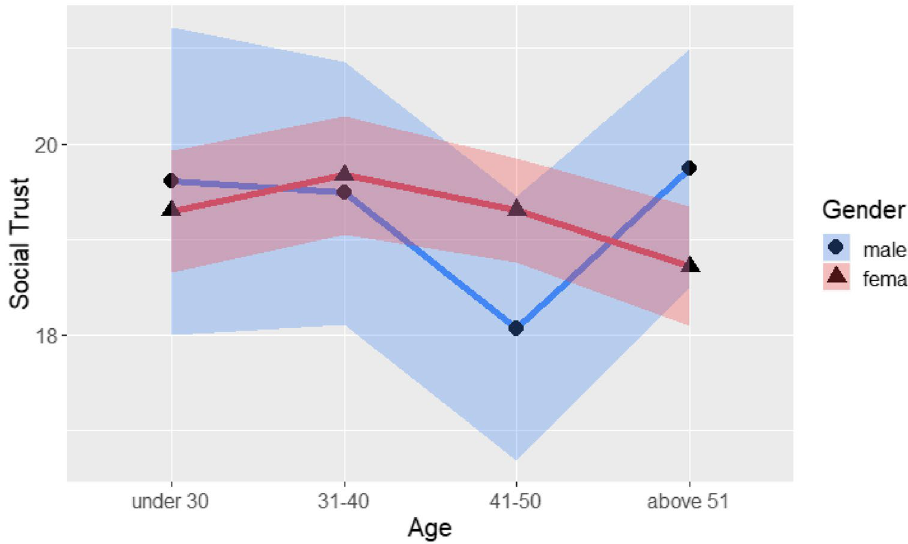
Figure 5. Social trust score with age and gender.